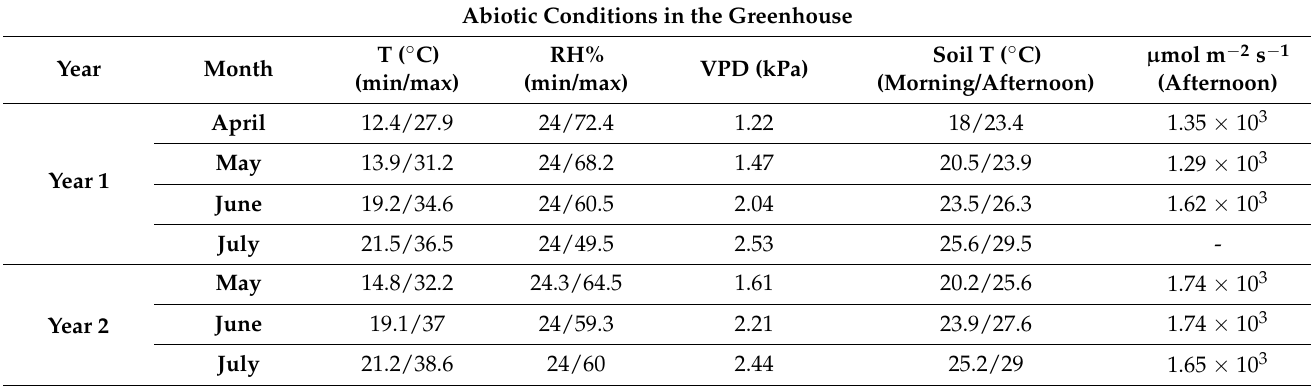
Table 2. Abiotic conditions in the greenhouse during the experimental